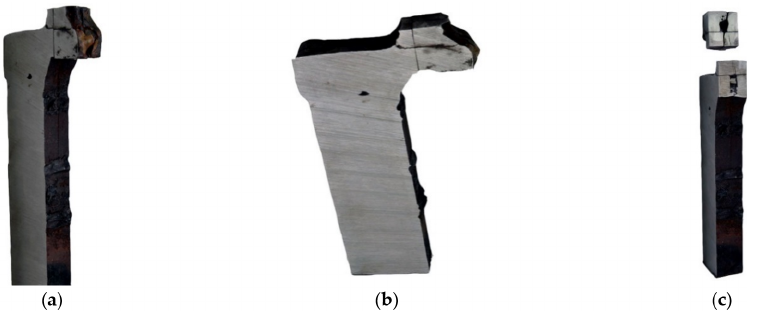
Figure 15. A macroscopic examination of crack 2 (handy-size bulk carrier 30206 DWT): ( a ) the crack running across parts I, II, and III; ( b ) the cross-cut of part II in the area of the origin of crack 2; and ( c ) the cross-cut of part II in the area of the origin of crack